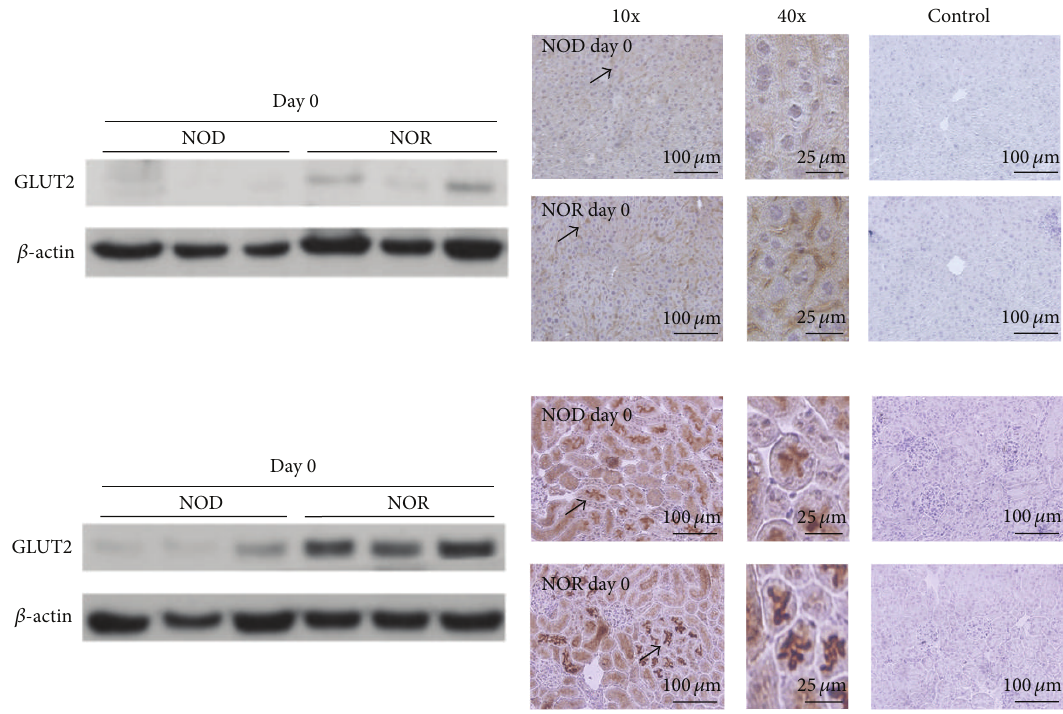
Figure 5: Western blot analysis and immunohistochemical stainings of GLUT2 expressions in thelivers and kidneys of non-STZ treated NOD and NOR mice. Representative images are shown demonstrating GLUT2 expression levels in livers (upper panel) and kidneys (lower panel) of NOD and NOR mice via western blot (left) and immunohistochemical stainings (right), prior to STZ application (day 0). Hematoxylin counterstaining was performed following anti-GLUT2 antibody application. Immunohistochemistry images show the corresponding tissues at 10x magnification on the left side, and at 40x magnification in the middle depictions. Arrows are placed for comparison of the staining intensities. Control tissues, treated with secondary antibody only, are shown at